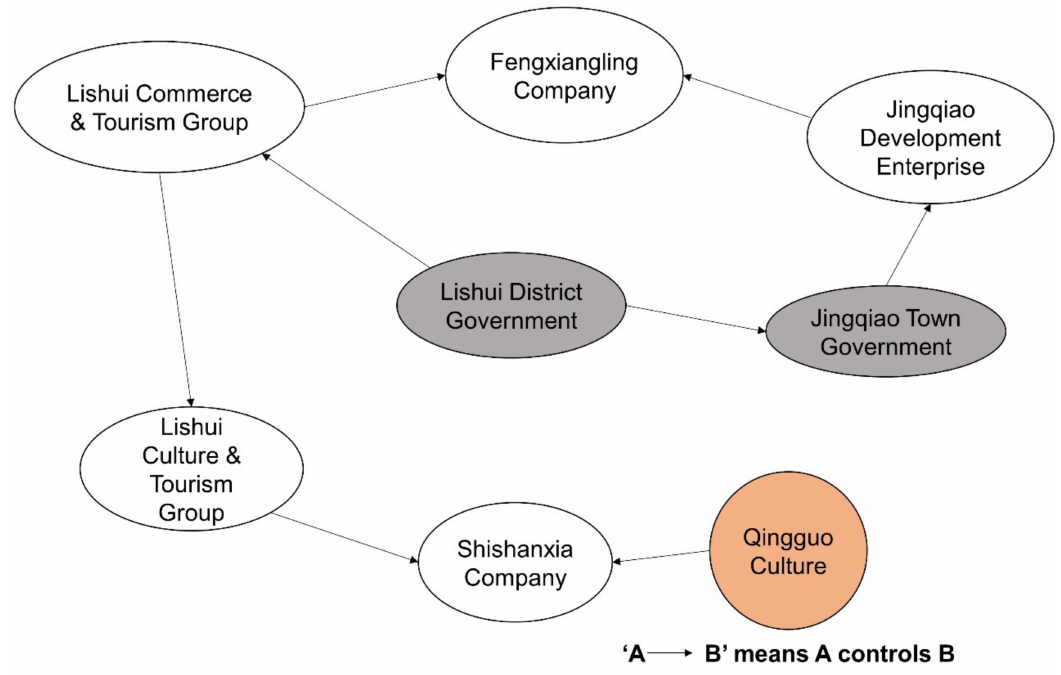
Figure 3. Diagram of investment enterprise (data from Baidu Enterprise Credit Platform)